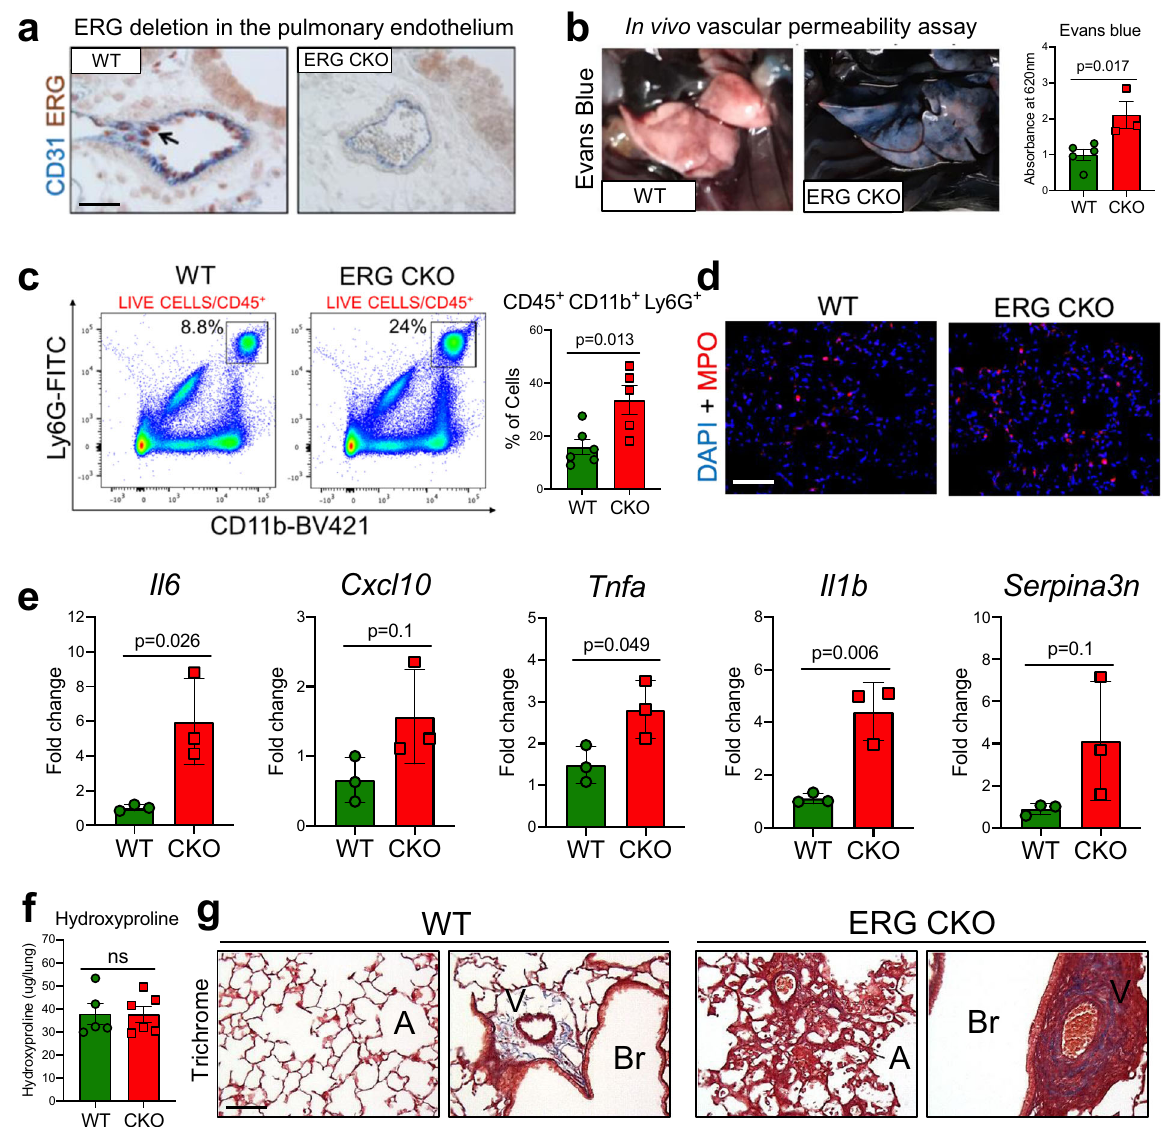
Fig. 6 Conditional deletion of ERG in ECs promotes pulmonary vascular leak, vessel remodeling, and lung in fl ammation. a Representative images of lung sections from control and Erg CKO animals (young mice, 2-month-old) after tamoxifen injections, stained with an anti-ERG antibody (red) and co- stained with an anti-CD31 antibody (blue) to evaluate Erg deletion in lung ECs (WT n = 6; CKO n = 5). Scale bar: 20 μ M. b Vessel permeability assessed by i.v. injection of Evans blue (WT n = 5; CKO n = 3). Values are summarized as mean and SD and analyzed using a two-tailed Student ’ s t -test. Source